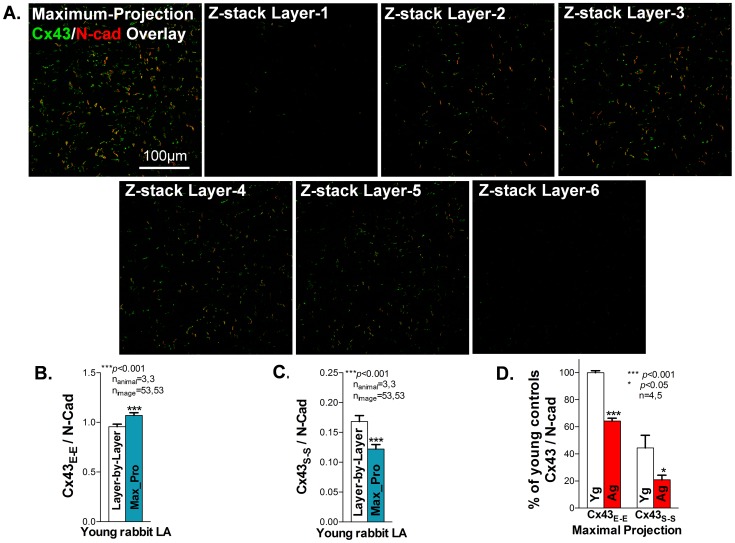
Comparing results of quantitative Cx43 distribution and abundance using layer-by-layer and maximum projection imaging quantification.
A. Representative sequential confocal images of Cx43 (green) and N-Cad (red) double immuno-stained young rabbit LA from focal layer 1 to layer 6. B. Histogram of quantified Cx43 immuno-stained signals from the maximum projection image. C-D. Summarized data of quantified Cx43E-E and Cx43S-S on young rabbit LA (n = 3; 53 images of each rabbit LA section) using layer-by-layer (B) and maximum projection (C) imaging quantification approaches. D. Pooled data of quantified Cx43E-E and Cx43S-S in young and aged rabbit LA using Layer-by-Layer imaging quantification from Z-stack confocal images (n = 4, 5; *p<0.001).